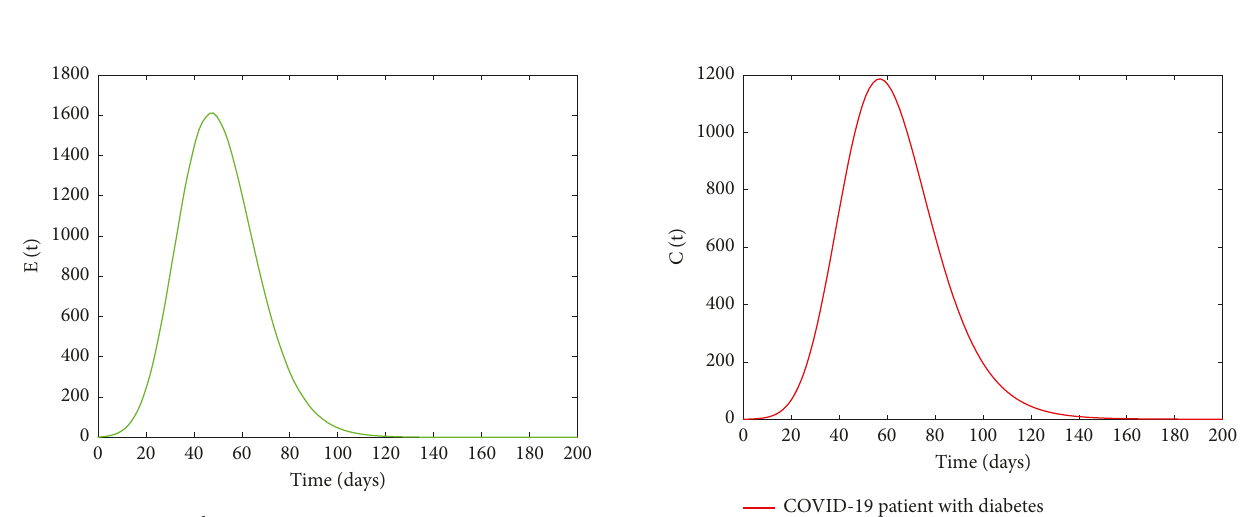
Figure 4: Behaviour of susceptible individual.